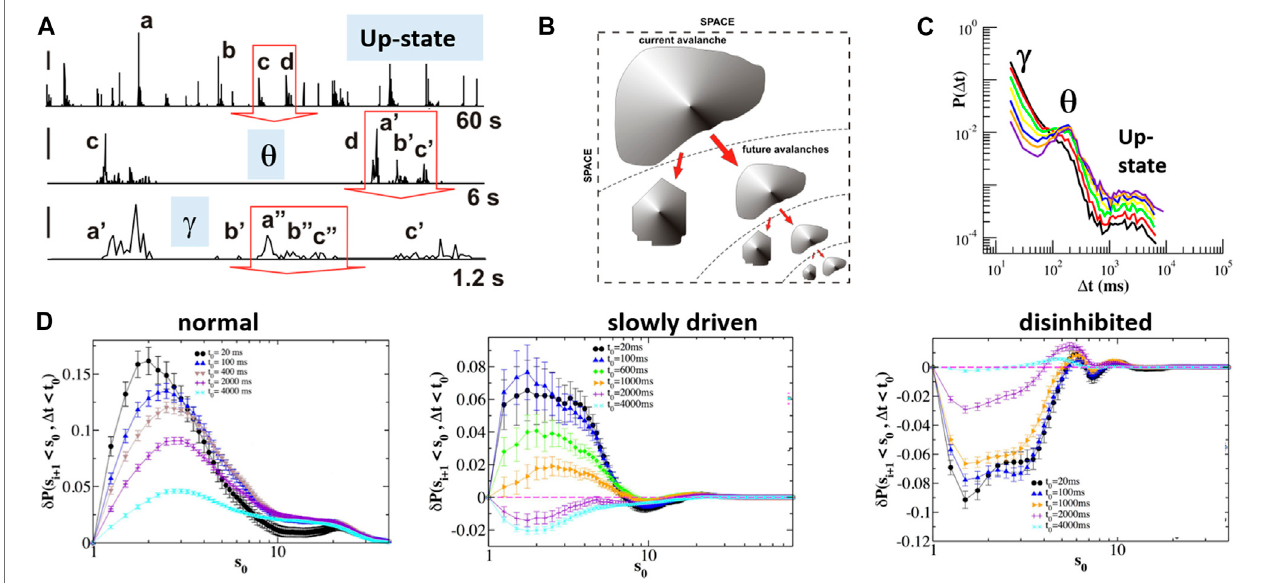
FIGURE 10 | Size-dependent nesting in the temporal self-organization of neuronal avalanches. (A) Time course of integrated avalanche activity at three different resolutions. Note the presence of intermittent bursts of successively smaller size [e.g., ( a, b, c, d )] that are recursively embedded at smaller time scales [e.g., d - > ( a ′ , b ′ , c ′ ); b ′ - > (a ″ , b ″ , c ″ )]. Red arrows indicate the zoomed-in period from larger time scale (single organotypic culture; slowly driven; cf. Figure 9A ). Labels place each time scale within the corresponding up-state and nested oscillation regimes. (B) Sketch of size-dependent nesting of avalanches begetting future avalanches ( A, B modi fi ed and reproduced with permission from [11]). (C) Quiet time distribution of avalanches revealing power law decay with θ -oscillation peak and indicated γ -oscillation and up-state regime (organotypic cortex cultures) (modi fi ed and reproduced under CC-BY license from [103]). (D) Quanti fi cation of the dependency in preavalanche size and successive quiet time. Avalanches beget future avalanches ( left ) absent driving and during periodic, slowly driven condition ( middle ). This relationshipisreversedindisinhibitedcultures( right ).The Y -axisdisplaystheprobabilitythatthenextavalanchewithinobservationwindowt 0 issmallergivensizes 0 ofthe current avalanche (reproduced under CC-BY license from